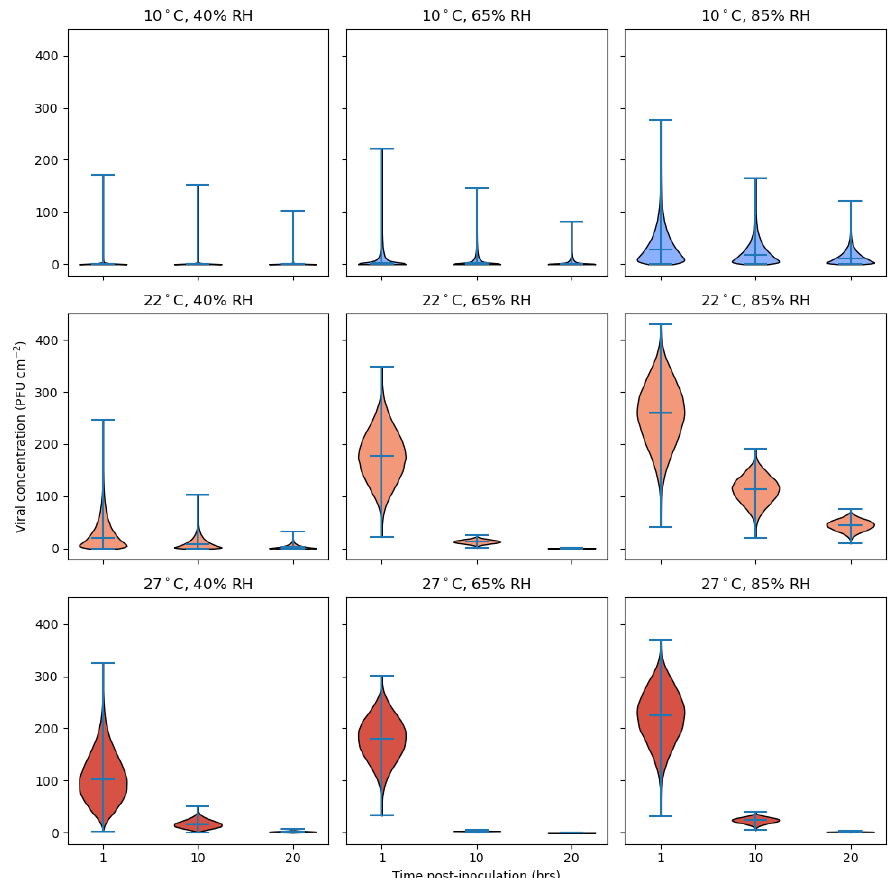
Figure 8. Estimates of viable SARS-CoV-2 transferred to human finger under different environmental conditions. The horizontal lines within each violin indicate the median viral concentration as well as the extrema. Transfer efficiencies were sampled from beta distributions obtained from the fitted regression model with parameters fixed at posterior median values for a melamine surface (see Table S9 Supplementary Information).